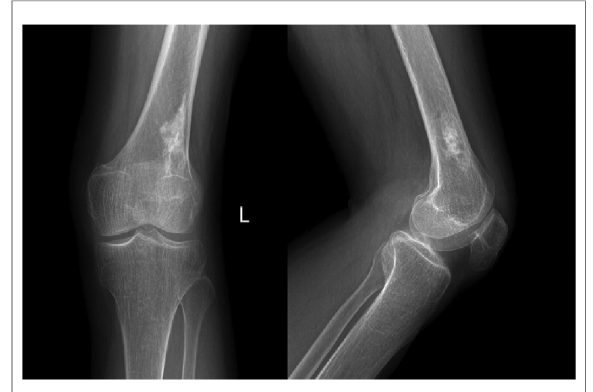
FIGURE 1 Anteroposterior and lateral radiographs of the left knee showing a patchy high-density shadow of the left distal femur without fracture or bone destruction.